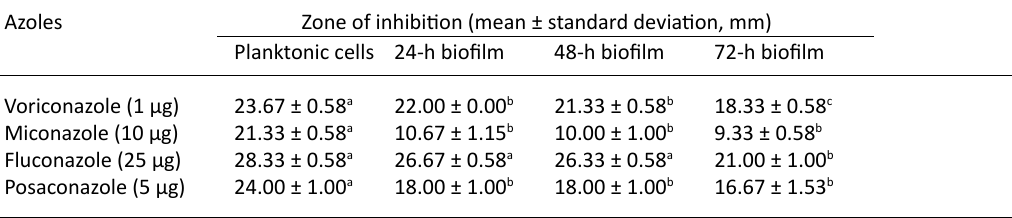
Table 1 . Antifungal susceptibility of Candida albicans planktonic cells and biofilms on PVC-ETT. Azoles Zone of inhibition (mean ± standard deviation, mm) Planktonic cells 24-h